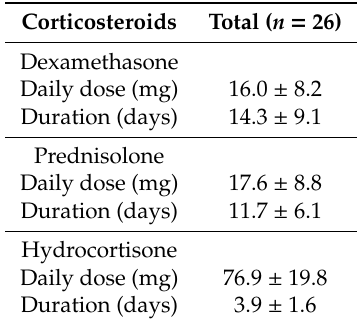
Table 2. Daily dose and duration of corticosteroid therapy in the perioperative period of brain tumor surgery.